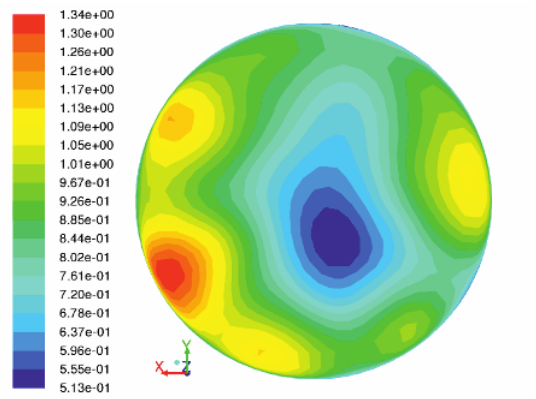
Figure 22: Deviation of velocity in metering run